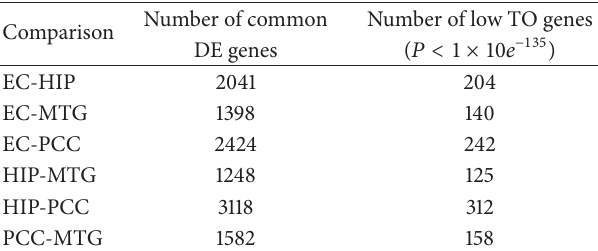
Table 2: Number of genes common to the set of DE genes of the regions being compared and the number of genes with low topological